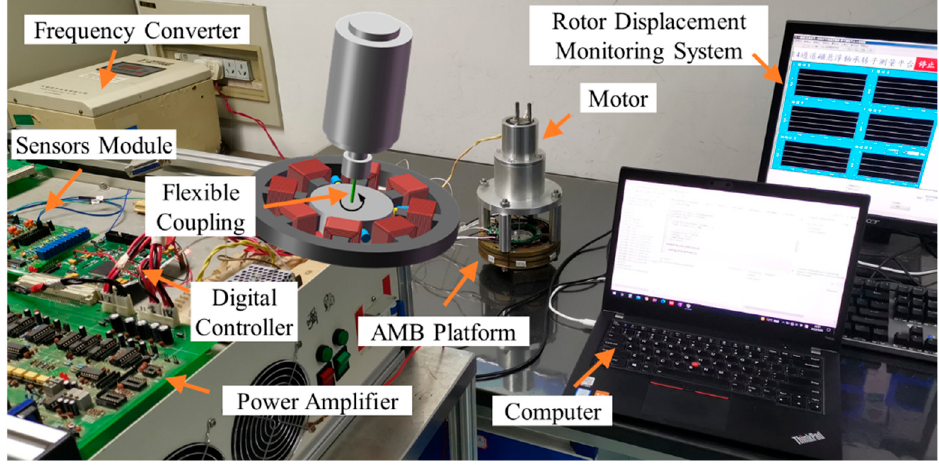
Figure 10. Photograph of the constructed AMB platform.